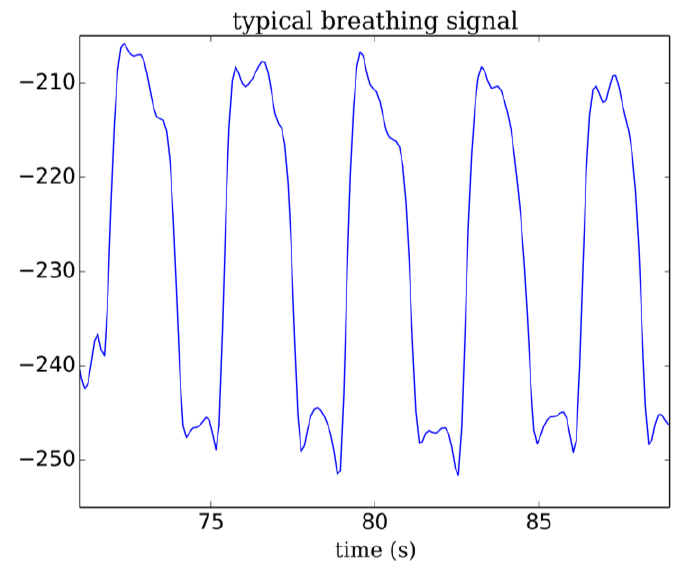
Figure 12. Typical breathing signal versus time (s). Arbitrary